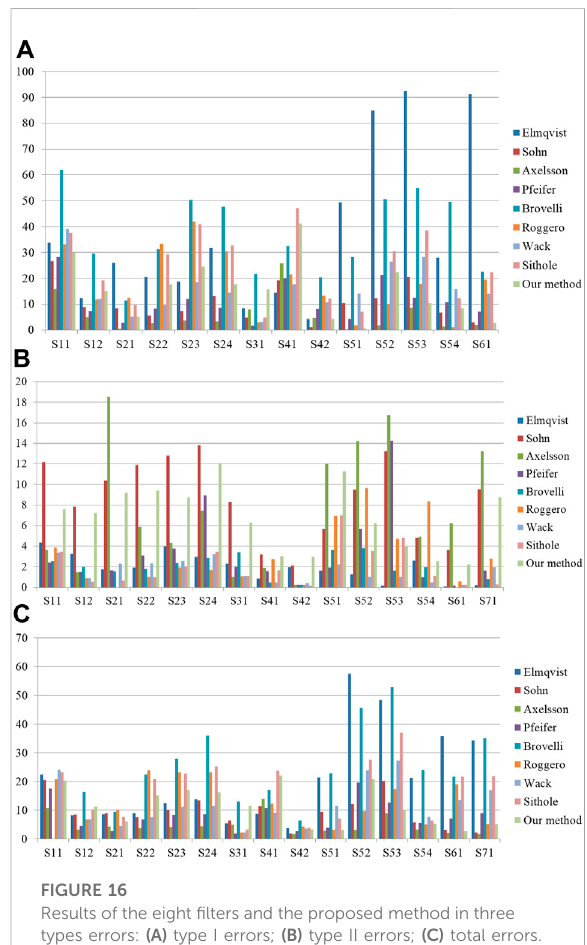
FIGURE 16 Results of the eight fi lters and the proposed method in three types errors: (A) type I errors; (B) type II errors; (C) total